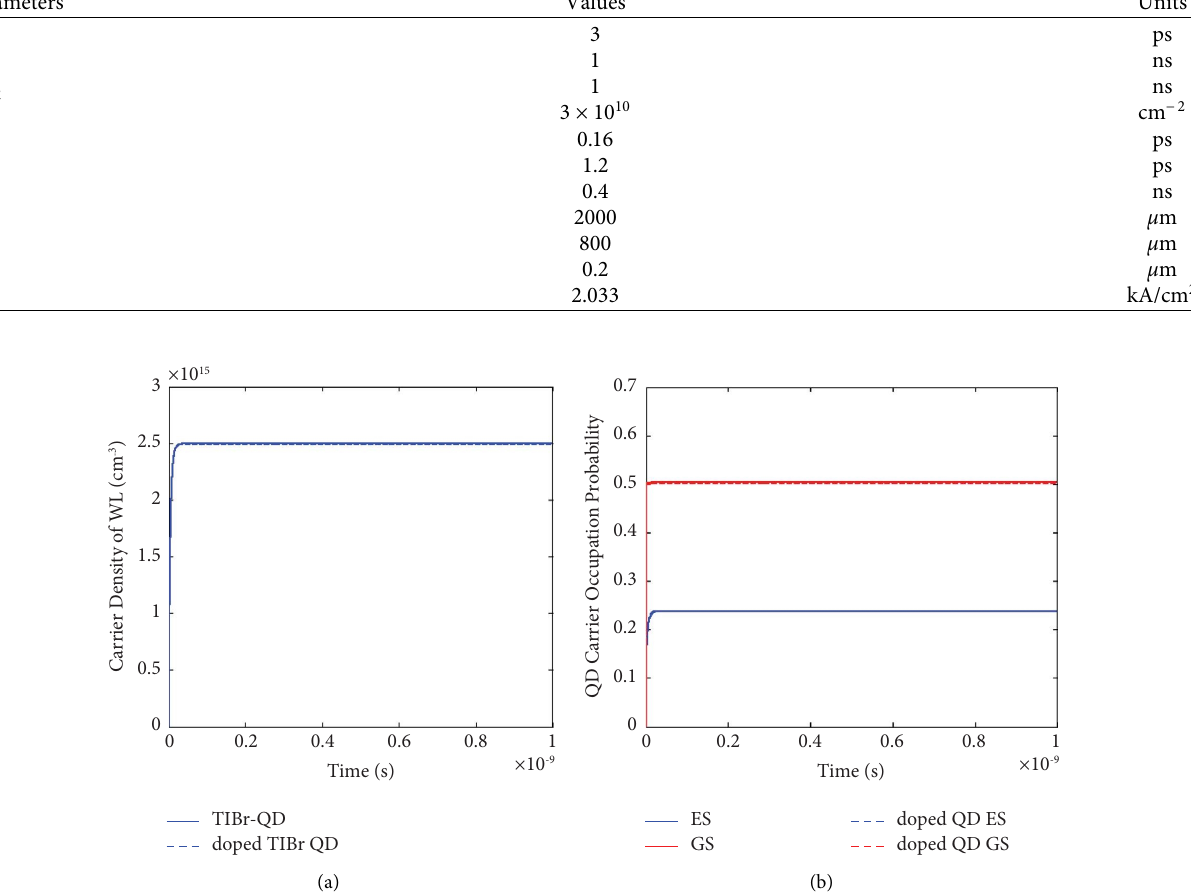
Figure 5: Times series of (a) WL carrier density and (b) QD occupation of GS (red curve) and ES (blue